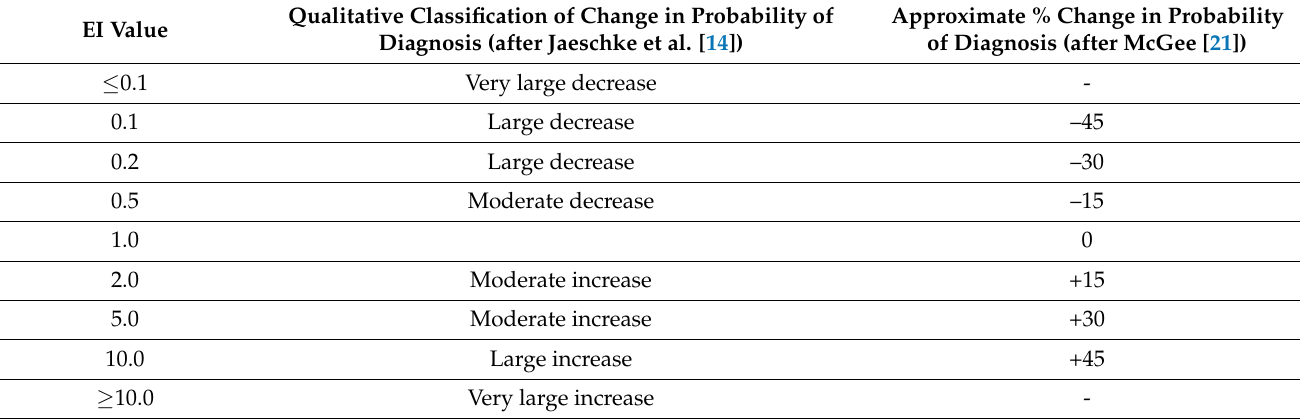
Table 6. Suggested classification of EI